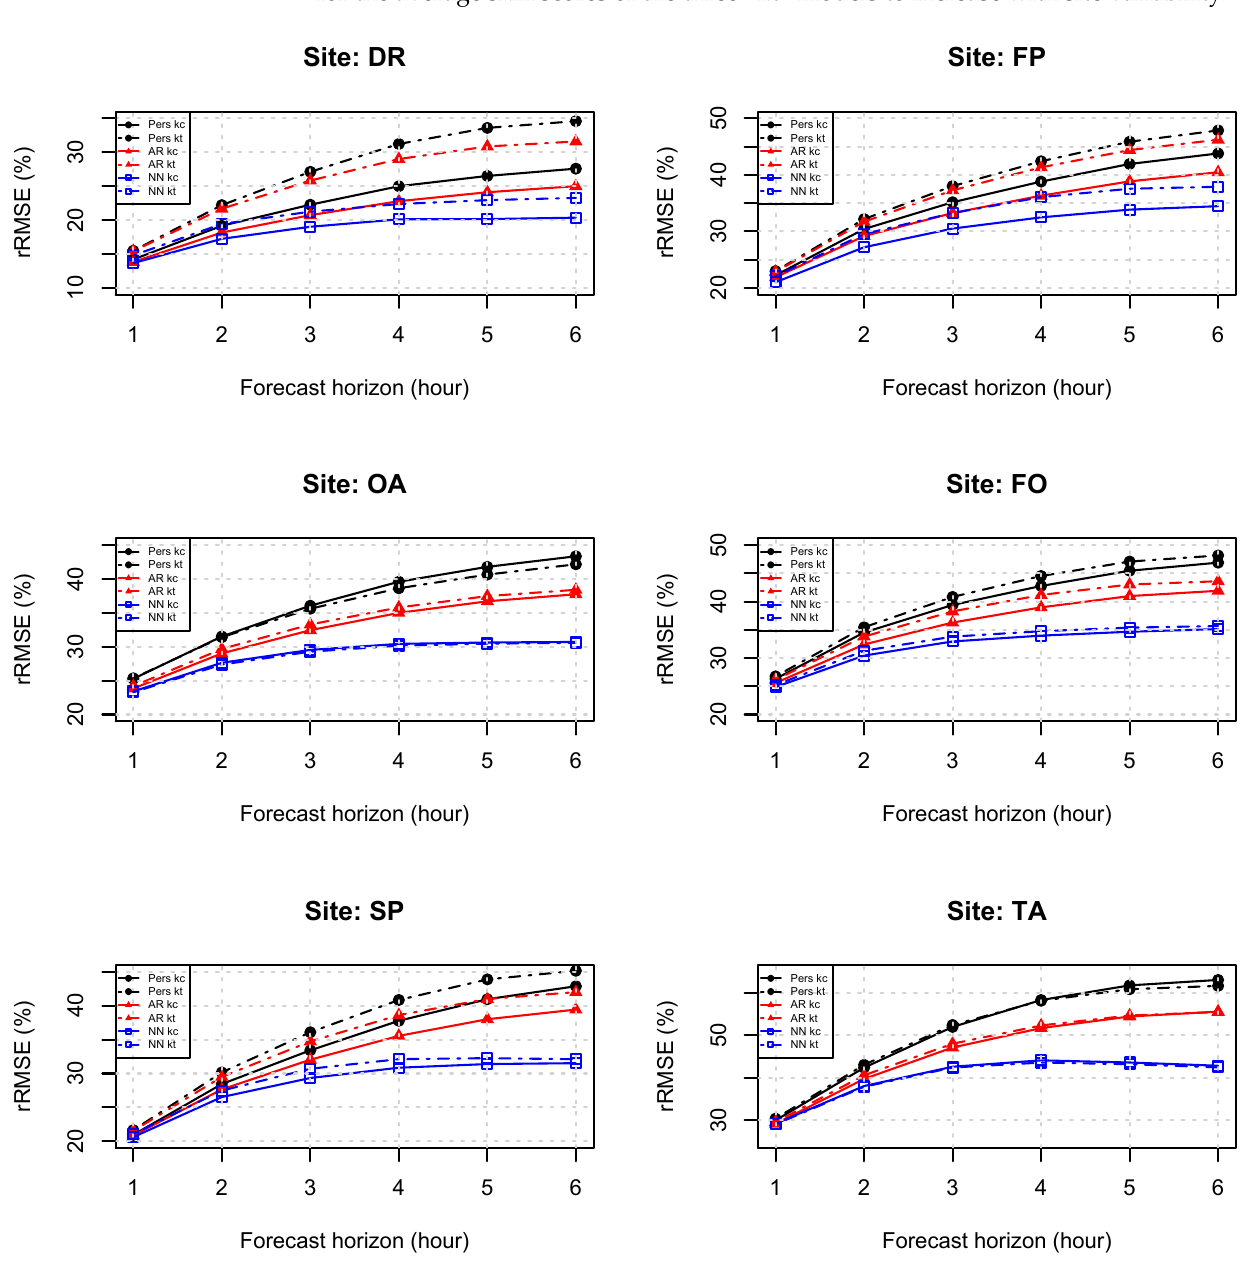
Figure 4. Relative RMSE of the different forecasting techniques for all the sites under